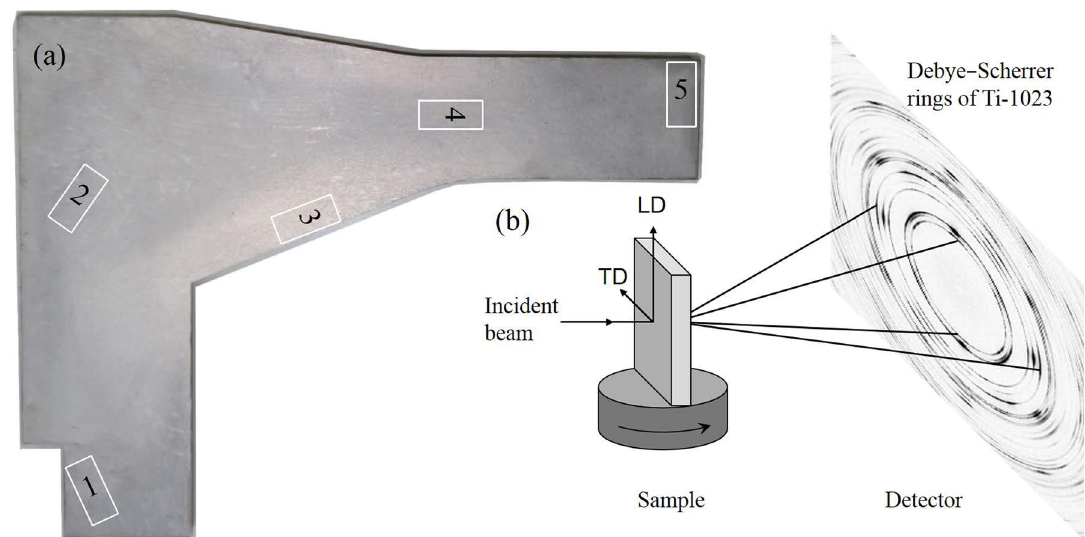
Figure 1. (a) Samples cut from different regions of the Ti-1023 forged disk and the LD of each sample is parallel to the flow line. (b) Schematic geometry of the texture